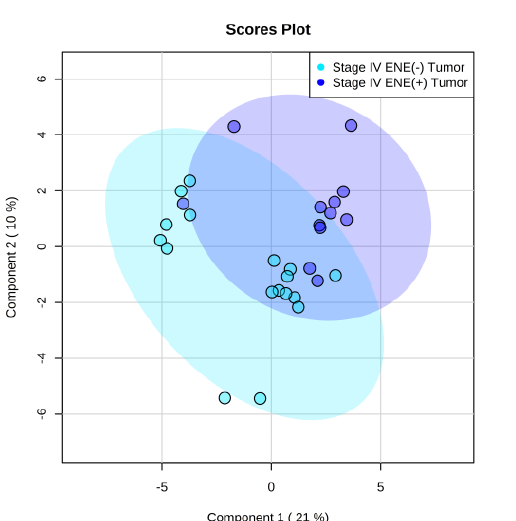
Figure 1. Metabolite-distribution of tumor and adjacent normal tissue at stage IV according to extranodal extension (ENE) status: ENE (-) ( A ) and ENE( + ) ( B ). Metabolite-concentration distribution of tumor and adjacent normal tissue at stage IV using the partial least squares discriminate analysis statistical method. Elliptical shape displayed 95% confidence region. ( A , B ): tumor / normal tissue = red / green, ( C ): tumor ENE(-) / ENE( + ) = cyan / blue. Table 3. Altered metabolites between tumor and adjacent normal tissue at stage IV oral squamous cell carcinoma tumors. OSCC Tissue